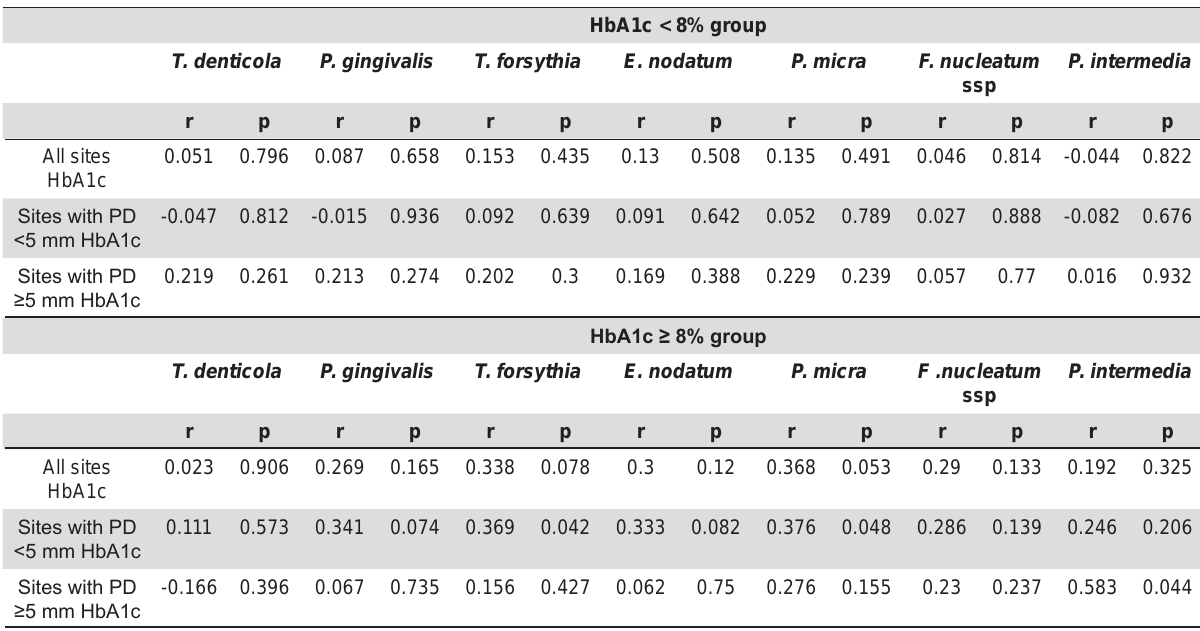
Table 4- (cid:3)(cid:38)(cid:82)(cid:85)(cid:85)(cid:72)(cid:79)(cid:68)(cid:87)(cid:76)(cid:82)(cid:81)(cid:3)(cid:70)(cid:82)(cid:72)(cid:73)(cid:191)(cid:70)(cid:76)(cid:72)(cid:81)(cid:87)(cid:86)(cid:3)(cid:11)(cid:85)(cid:12)(cid:3)(cid:73)(cid:82)(cid:85)(cid:3)(cid:87)(cid:75)(cid:72)(cid:3)(cid:85)(cid:72)(cid:79)(cid:68)(cid:87)(cid:76)(cid:82)(cid:81)(cid:86)(cid:75)(cid:76)(cid:83)(cid:3)(cid:69)(cid:72)(cid:87)(cid:90)(cid:72)(cid:72)(cid:81)(cid:3)(cid:72)(cid:68)(cid:70)(cid:75)(cid:3)(cid:83)(cid:72)(cid:85)(cid:76)(cid:82)(cid:71)(cid:82)(cid:81)(cid:87)(cid:68)(cid:79)(cid:3)(cid:83)(cid:68)(cid:87)(cid:75)(cid:82)(cid:74)(cid:72)(cid:81)(cid:3)(cid:68)(cid:81)(cid:71)(cid:3)(cid:43)(cid:69)(cid:36)(cid:20)(cid:70)(cid:3)(cid:79)(cid:72)(cid:89)(cid:72)(cid:79)(cid:86)(cid:3)(cid:70)(cid:82)(cid:81)(cid:86)(cid:76)(cid:71)(cid:72)(cid:85)(cid:76)(cid:81)(cid:74)(cid:3)(cid:68)(cid:79)(cid:79)(cid:3)(cid:86)(cid:76)(cid:87)(cid:72)(cid:86)(cid:3)(cid:68)(cid:81)(cid:71)(cid:3)